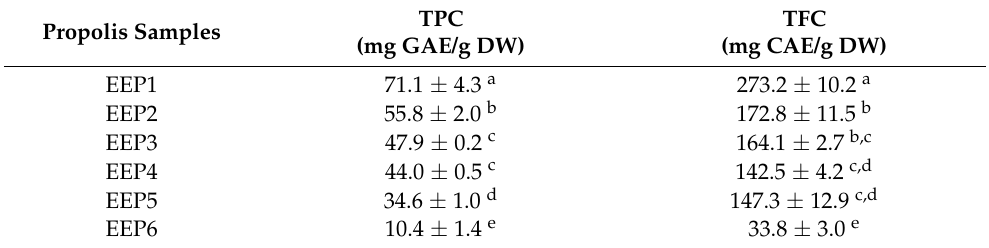
Table 1. Concentrations of phenols and flavonoids in dry weight (DW) of six propolis samples. Propolis